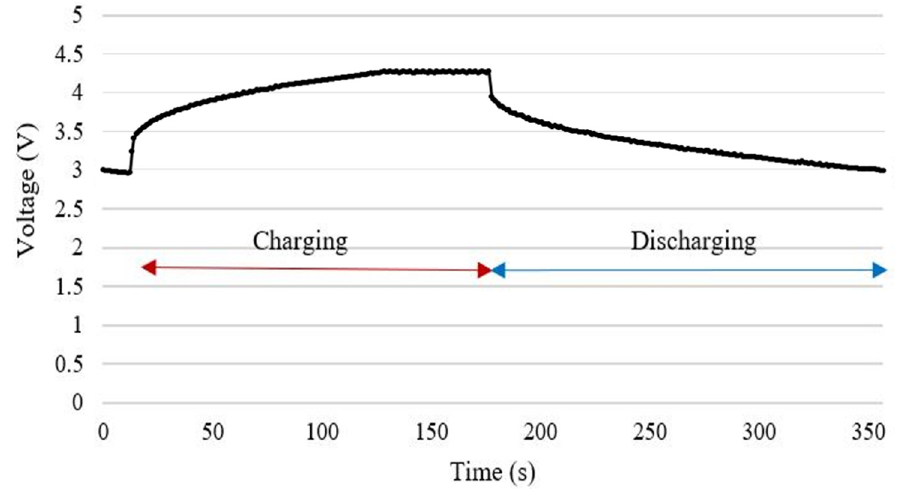
Figure 17. Charging and discharging process.